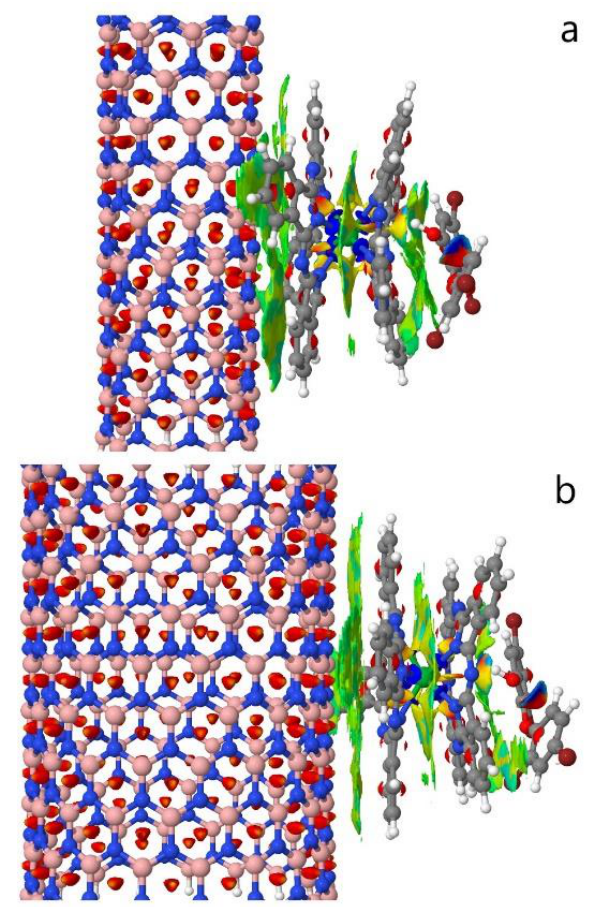
Figure 2. Non-covalent interaction between 6-OH-BDE-47 (6ohbde47) and zigzag ( a ) (9,0) and ( b ) (18,0) boron nitride nanotubes decorated with YbPc 2